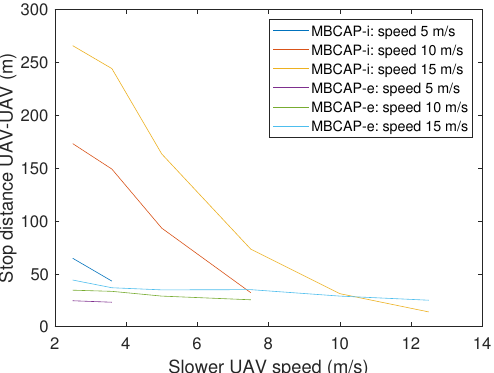
Figure 6. Distance between UAVs after stopping in a standard takeover, both flying at different speeds.